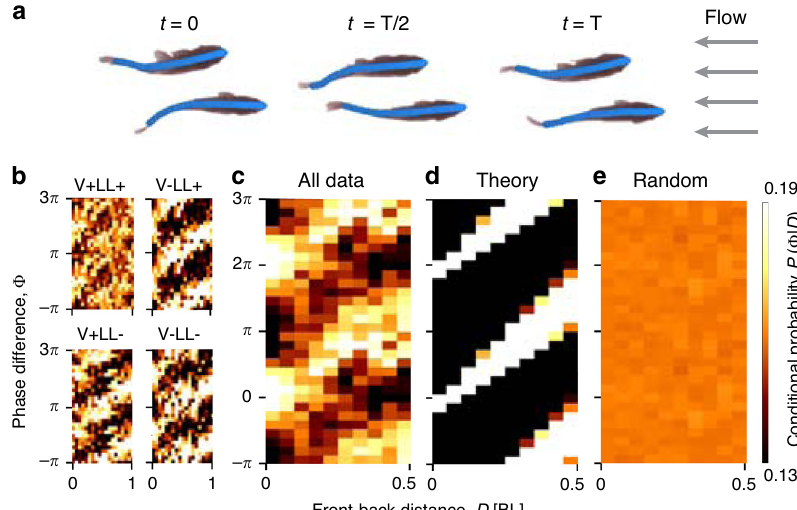
Fig. 3 Real fi sh exhibit vortex phase matching (VPM). a Example frames from a video recorded in the fl ow tank, overlaid with the result of deep-learning- based body posture tracking. The phase of the undulations of each fi sh was determined by the motion of the tail tip (measured at the caudal peduncle). b – e Occurrences of observed swimming relationships (probability density function) as a function of phase difference Φ and front-back distance D between leader and follower illustrated by colour-coding for one case with intact vision and lateral line (V + LL + ), three cases with impaired vision (V-LL + ), the lateral line (V + LL-) or both (V-LL-) ( b ), and all pooled data ( c ; V + LL + : n = 6, V + LL-: n = 5, V-LL + : n = 3, V-LL: n = 2; n given is the number of pairs). Data are duplicated twice along the phase difference axis to more clearly demonstrate the periodic pattern. Theoretical predictions ( d ) are derived by transforming observed swimming characteristics (including frequency f , front-back distance D and fl ow speed u ) using our model (Eq. (2)) with Φ 0 = Φ (cid:1) − 0.2 π . Φ (cid:1) is determined by comparing experimental data and theoretical predictions after Von Mises fi tting with a periodic least square fi tting algorithm 0 (Methods section). Randomised data ( e ) are generated by swapping two fi sh postures respectively from two randomly selected trials within same treatment (Supplementary Note